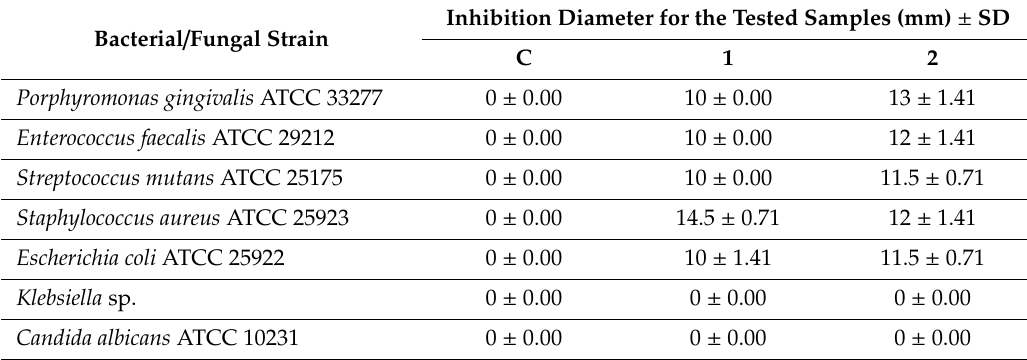
Table 3. The diameter of inhibition zone